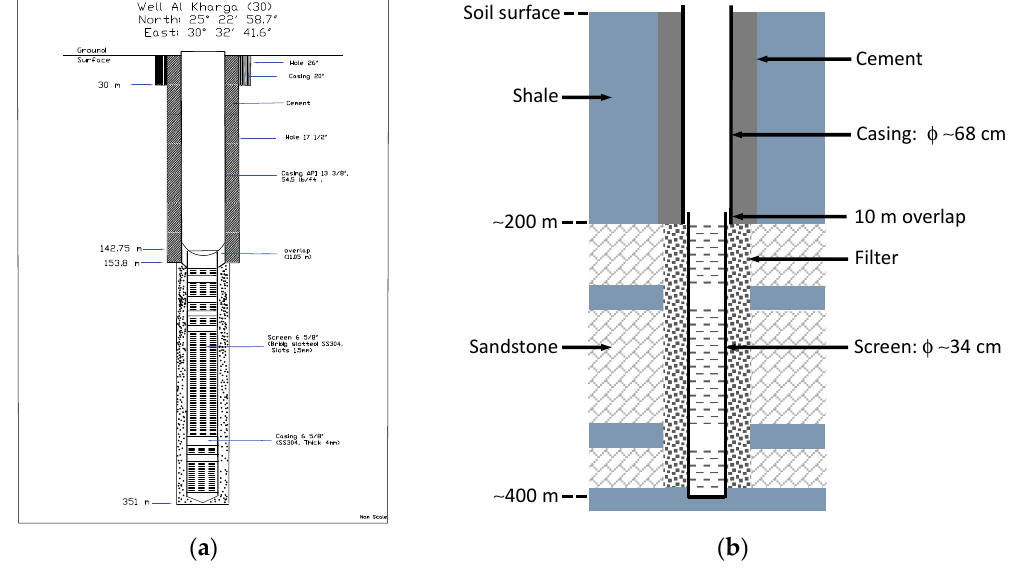
Figure 2. Technical log of well 11 ( a ); schematic geological and technical log of the wells, with orders of magnitude of the depth and diameter of the wells ( b ).